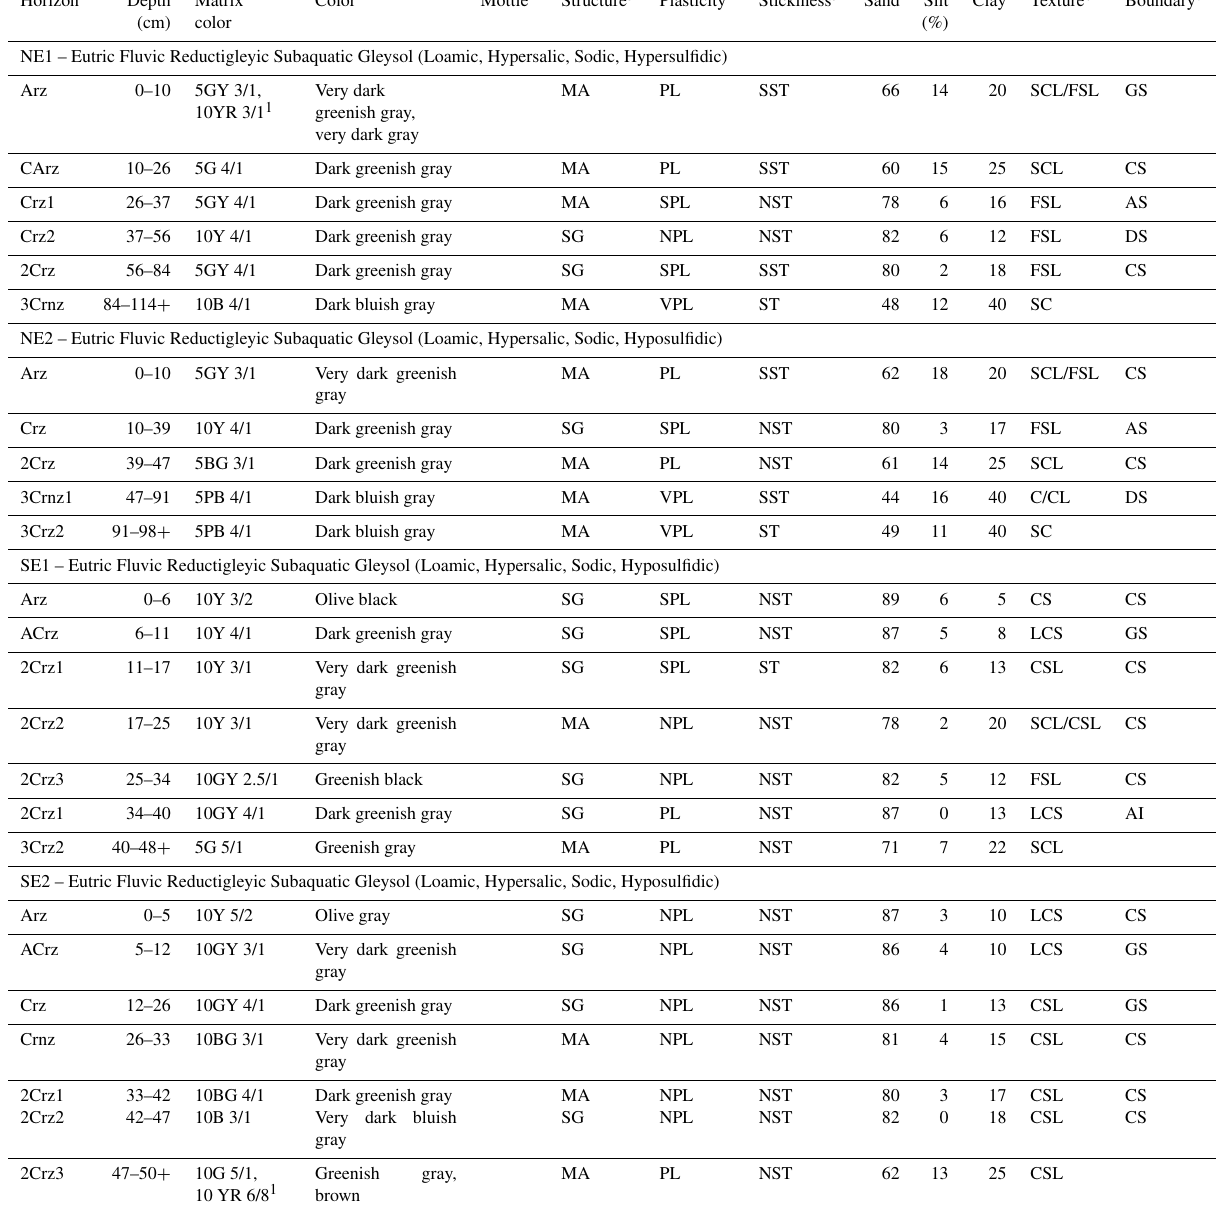
Table 1. Morphological properties and grain size composition of subaqueous soils from Brazilian seagrass meadows.